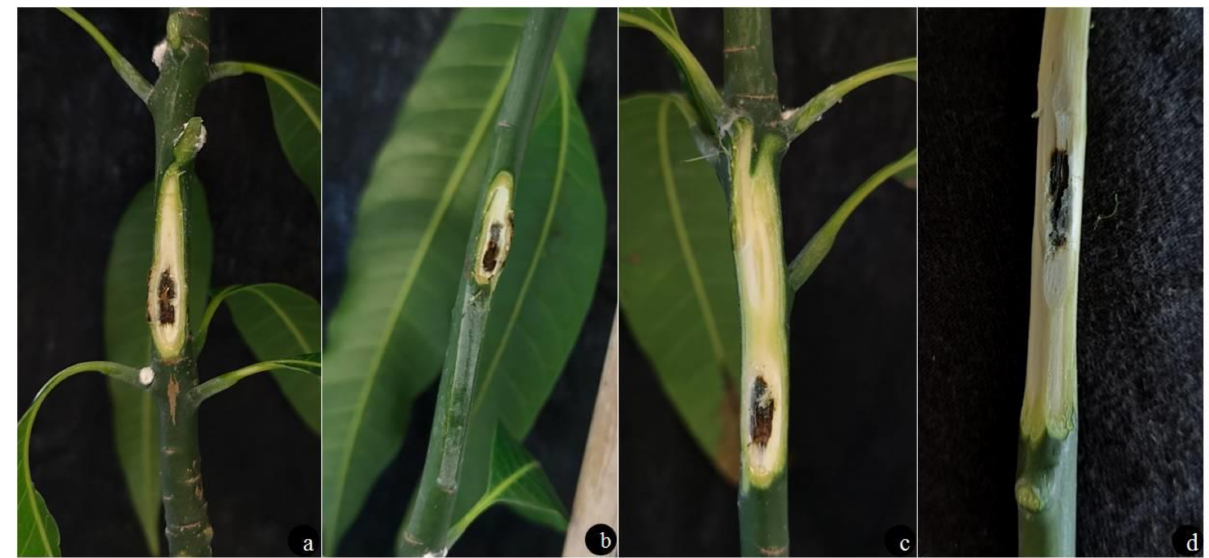
Figure 7. Internal discoloration of woody cankers in mango plants cv. Kensington Pride 30 days after inoculation with ( a ) Botryosphaeria dothidea ; ( b ) Lasiodiplodia theobromae ; ( c ) Diaporthe foeniculina ; ( d ) D . baccae .